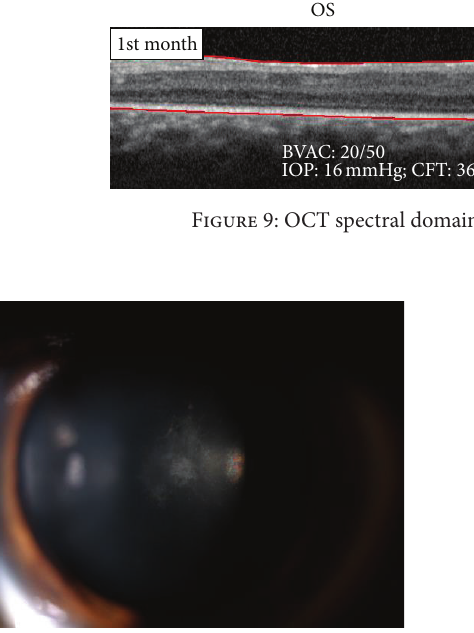
Figure 10: Biomicroscopy of left eye showed aggravation of subcap- sular